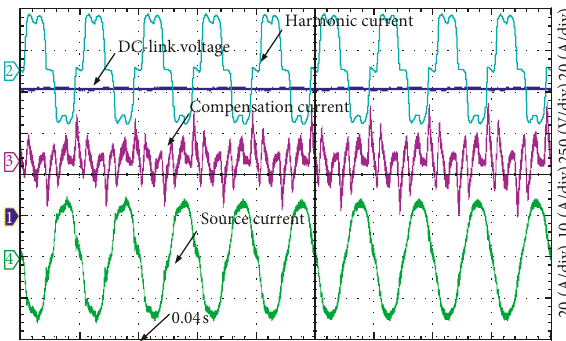
Figure 23: Experimental dynamic waveform after adding VR